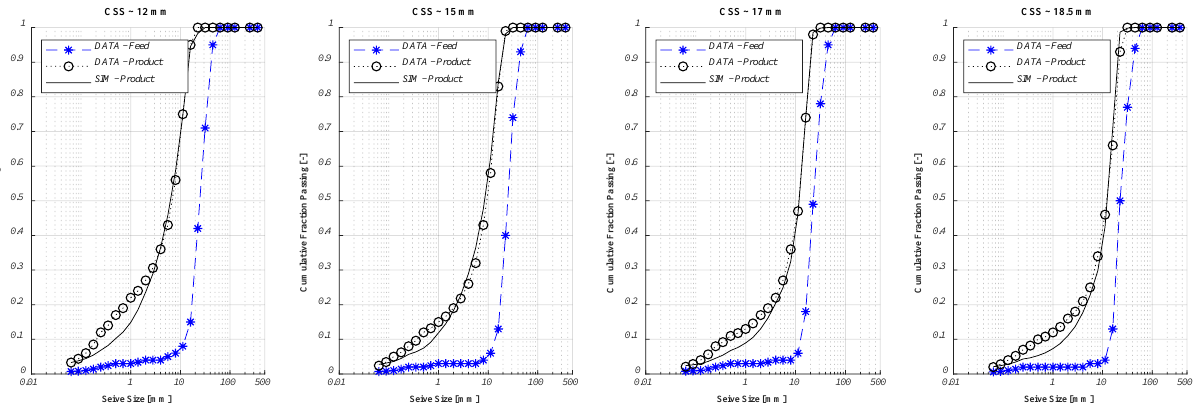
Figure 11. Crusher calibration result to the belt-cut experimental data in the cumulative domain.